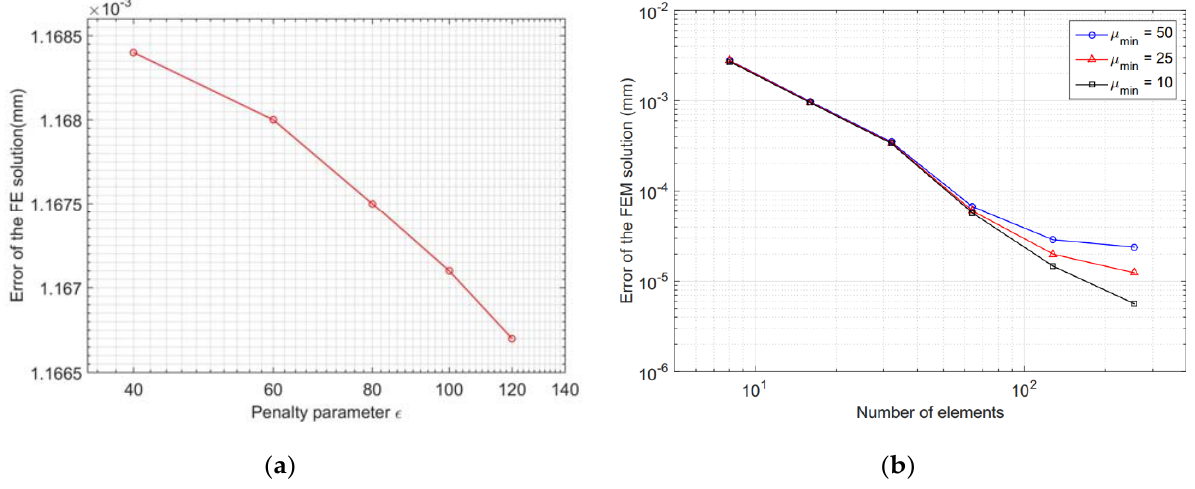
Figure 6. Influence of parameters ϵ and μ : ( a ) penalty parameter ϵ ; ( b ) parameter μ .